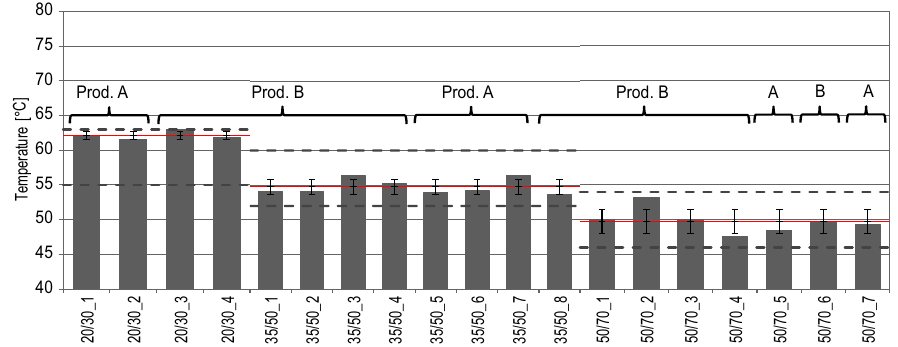
Fig. 2. Unmodified bitumen softening point